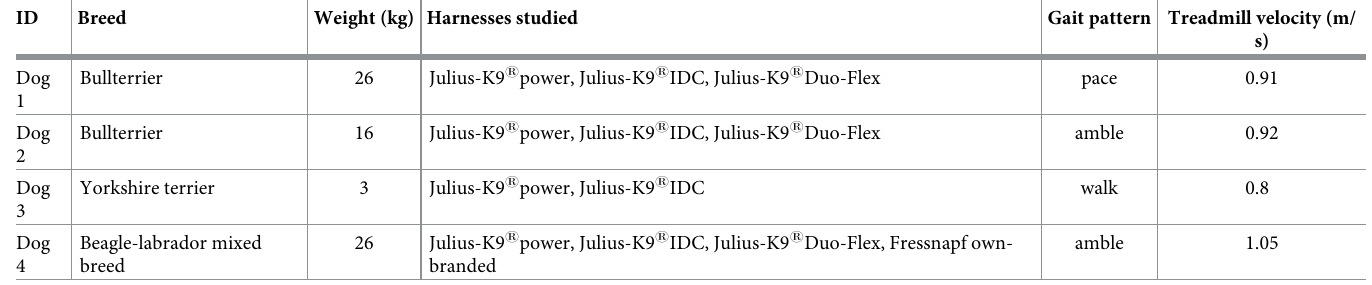
Table 1. Participating dogs and used harnesses. Gait patterns were identified by eye by an expert. Detailed description of each gait pattern can be found in [19].